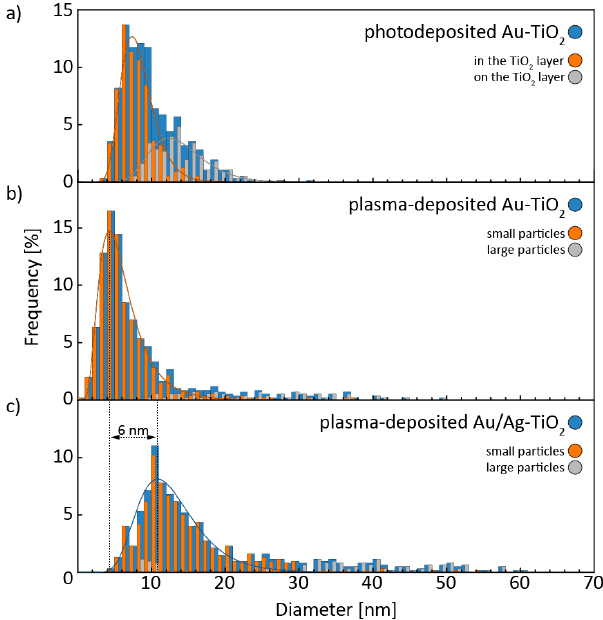
Figure 3. Size distributions of the noble metal nanoparticles in ( a ) photodeposited Au-TiO 2 , ( b ) plasma-deposited Au-TiO 2 and ( c ) plasma-deposited Ag/Au-TiO 2 . All size distributions were split into two sub-distributions each. As explained in the main text, “large particles” refers to particles we believe have coarsened, “small particles” to those that have not. Please note that the frequency values only apply to the size distribution of the whole sample, but not to the sub-distributions.